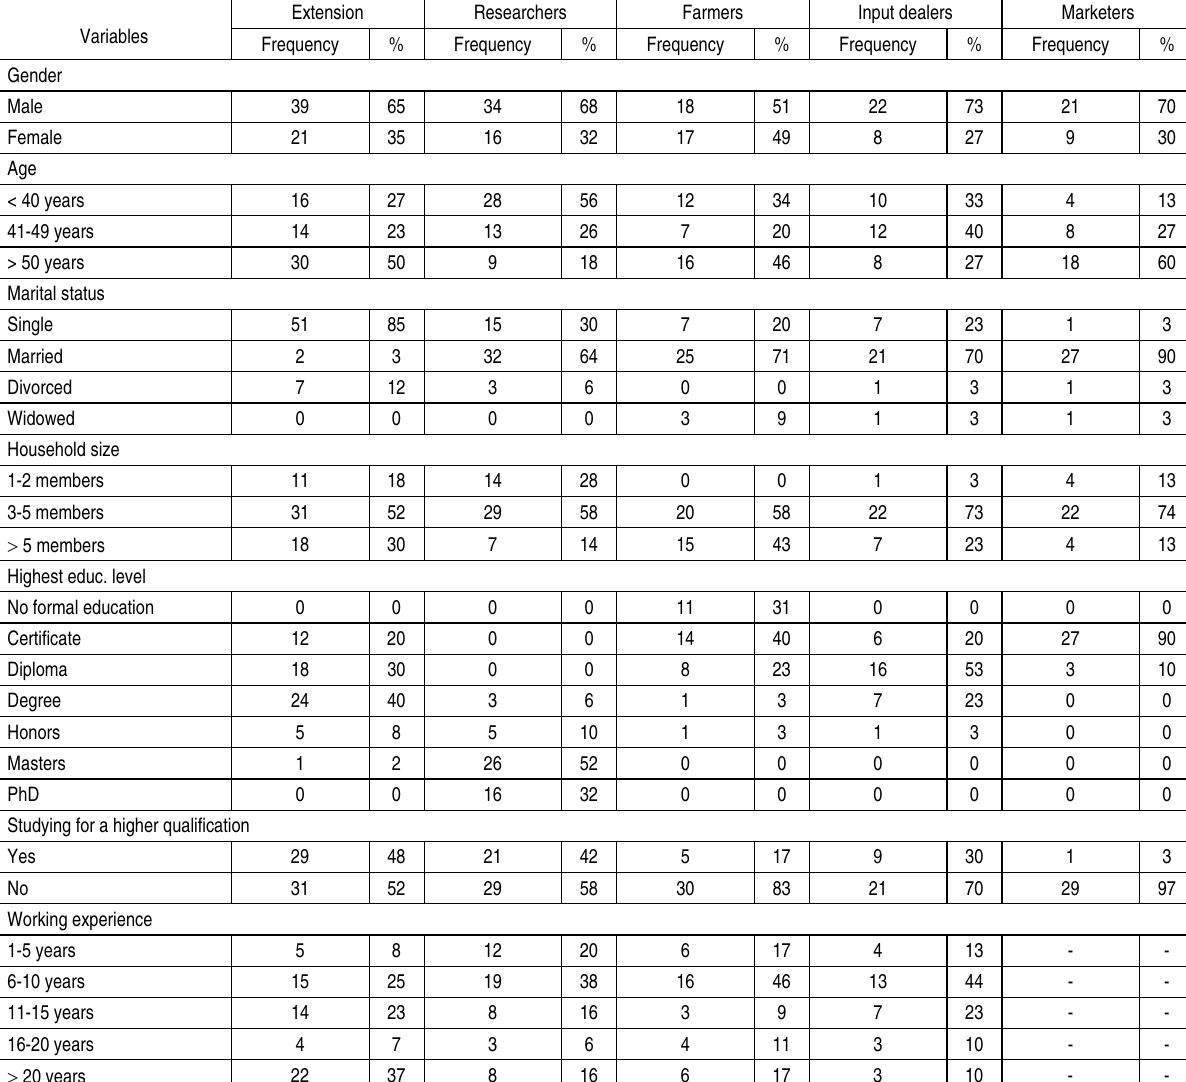
Table 1. Demographic characteristics of